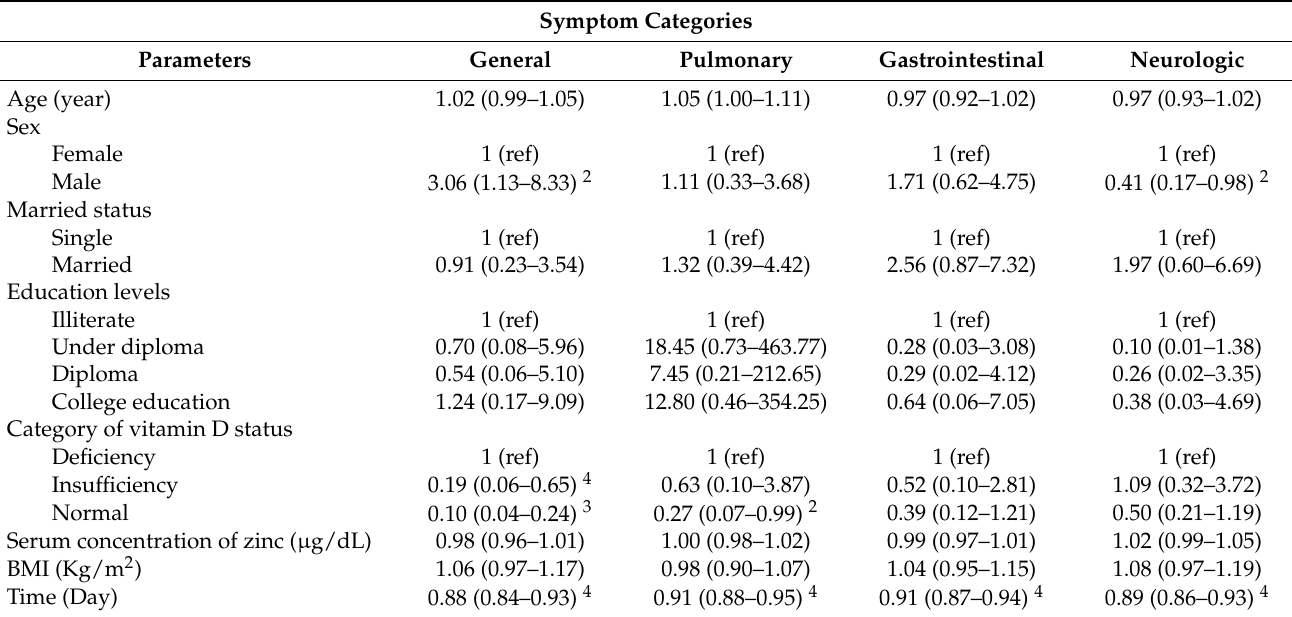
Table 4. Estimates of observed symptom progression of COVID-19 and the association with demographic, BMI, and laboratory parameters among infected patients ( n = 53) 1